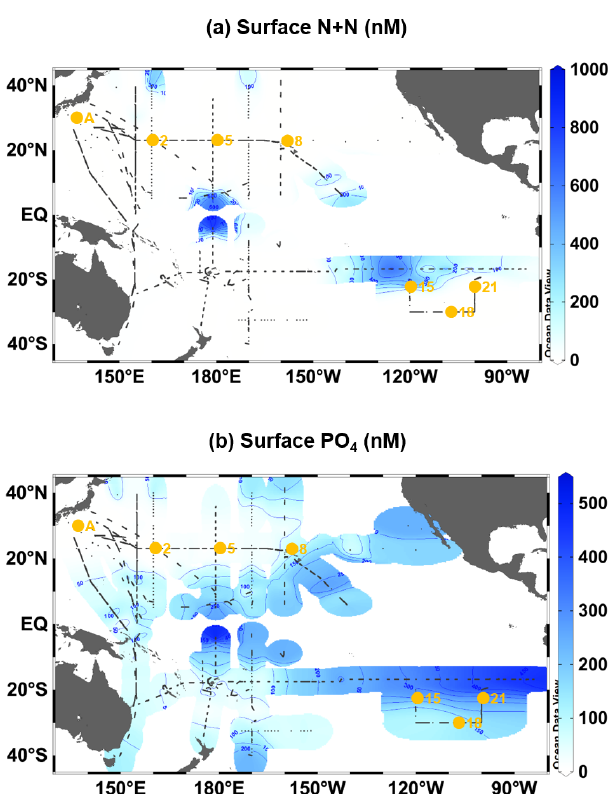
Figure A3. Surface distributions of nanomolar concentrations ( < 1000nM) of (a) N + N and (b) PO 4 in the oligotrophic Pacific Ocean (40 ◦ N–40 ◦ S). Small black dots denote sampling stations for the nanomolar PO 4 and N + N. Large orange circles denote the stations where the incubation experiments were